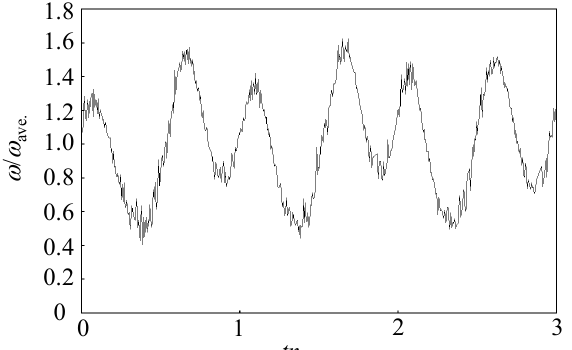
Fig. 22 Dimensionless angular velocity ω / ω ave. of rectangular plate versus reduced time tn for inertia-moment ratio I * = 0.75, Re ( V ) = 1.63 × 10 4 ( Re = 7.1 × 10 3 – 7.7 × 10 3 ), at depth-to-width ratio λ = 0.3, aspect ratio AR = 10.